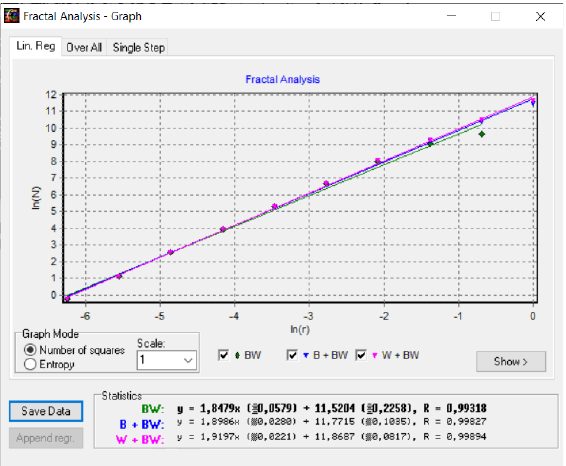
Figure 17. Graphic of fractal dimension for elected P 3 picture zone.